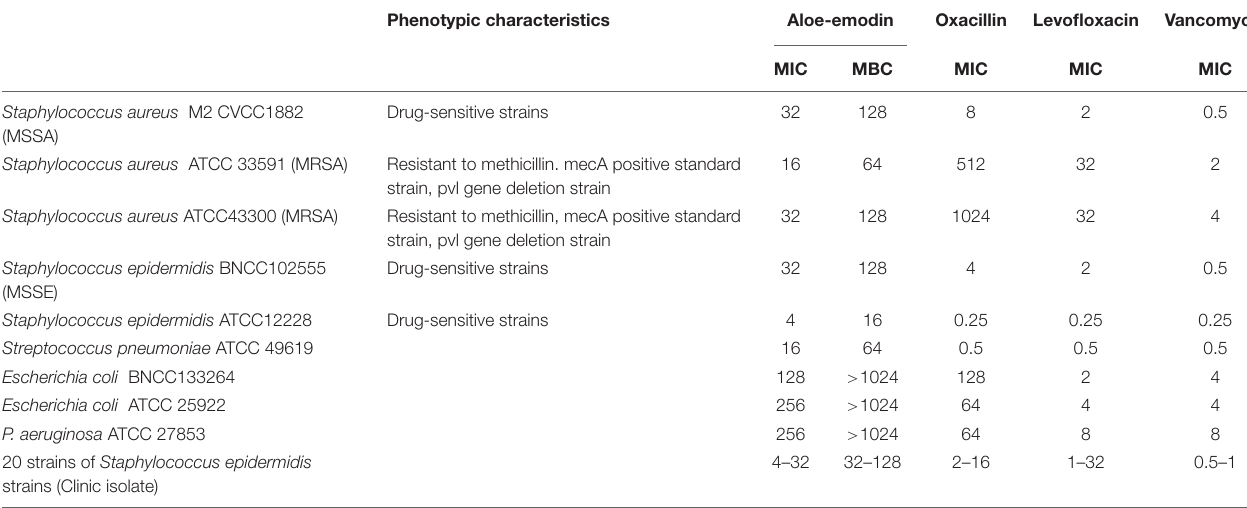
TABLE 1 | Minimum inhibitory concentrations ( µ g/mL) of aloe-emodin and other antibiotics against various bacterial species. Phenotypic